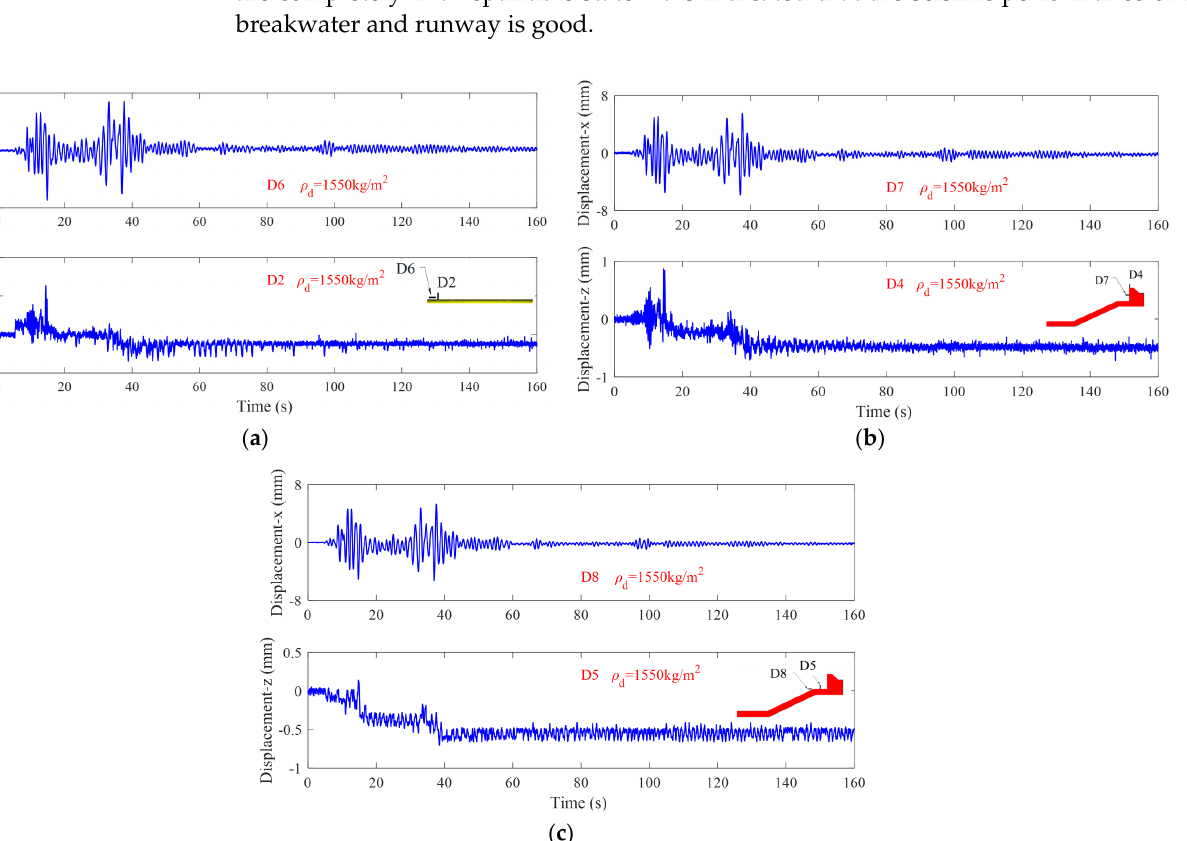
Figure 8. Dynamic responding of displacement of the revetment breakwater and runway. ( a ) Runway. ( b ) Caisson. ( c ) Revetment.